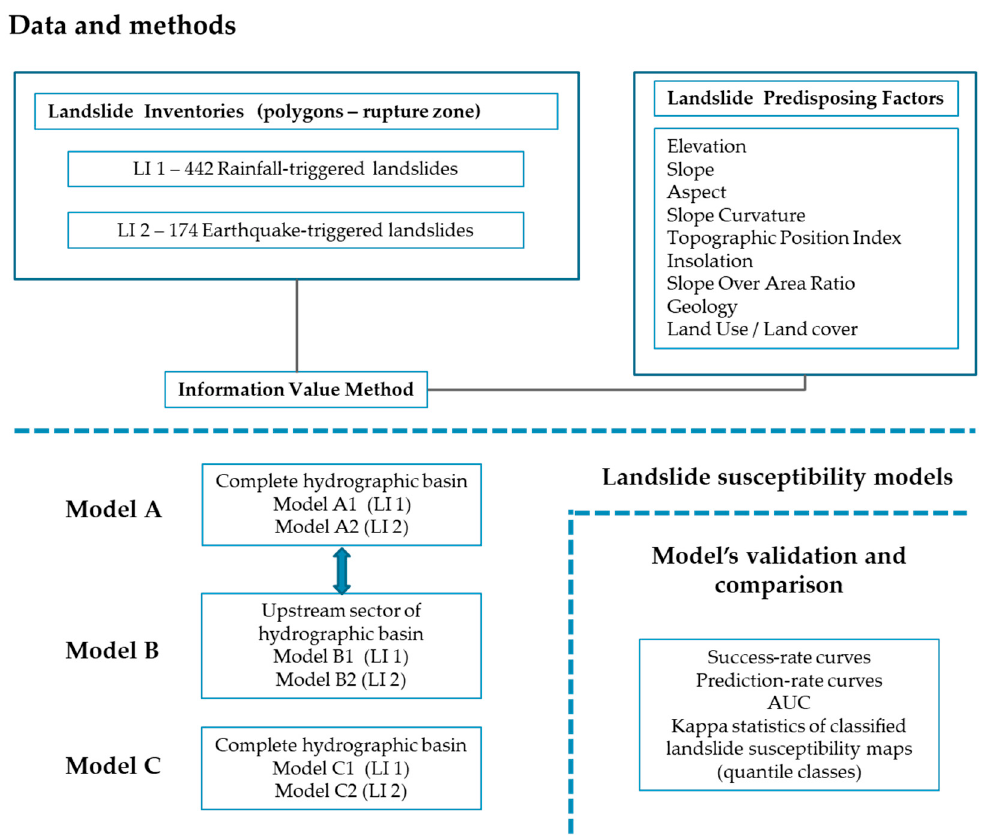
Figure 1. Data, methods, and modelling strategy.